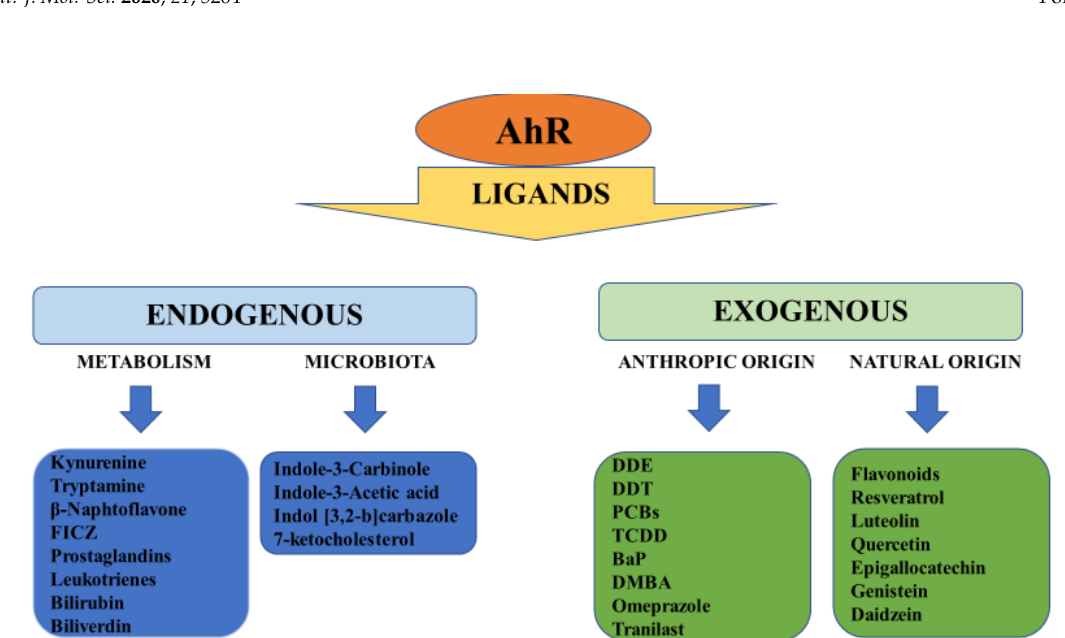
Figure 2. Endogenous and exogenous ligands of AhR. Endogenous ligands come from anabolism (kynurenine, tryptamine, β -Naphtoflavone, FICZ, prostaglandins, leukotrienes) and catabolism (bilirubin, biliverdin) of individuals and their commensal flora (microbiota: Indole-3-Carbinole; Indole-3-Acetic acid; Indol [3,2-b]carbazole; 7-ketocholesterol). Exogenous ligands can be manmade products which have a heterogeneous nature and uses (DDE, DDT, PCBs, TCDD, BaP, DMBA, Omeprazole Tranilast). Several exogenous ligands of natural origin are contained in plants and vegetable foods (Flavonoids, Resveratrol, Luteolin, Quercetin, Epigallocatechin, Genistein, Daidzein). DDE = dichlorodiphenyldichloroethylene; DDT = dichloro-diphenyl-trichloroethane; PCBs = polychlorinated biphenyls; TCDD = 2,3,7,8-tetrachlorodibenzo-p-dioxin; BaP = Benzo [a] pyrene; DMBA = 7,12-Dymethylbenz-[ α ]-anthracene